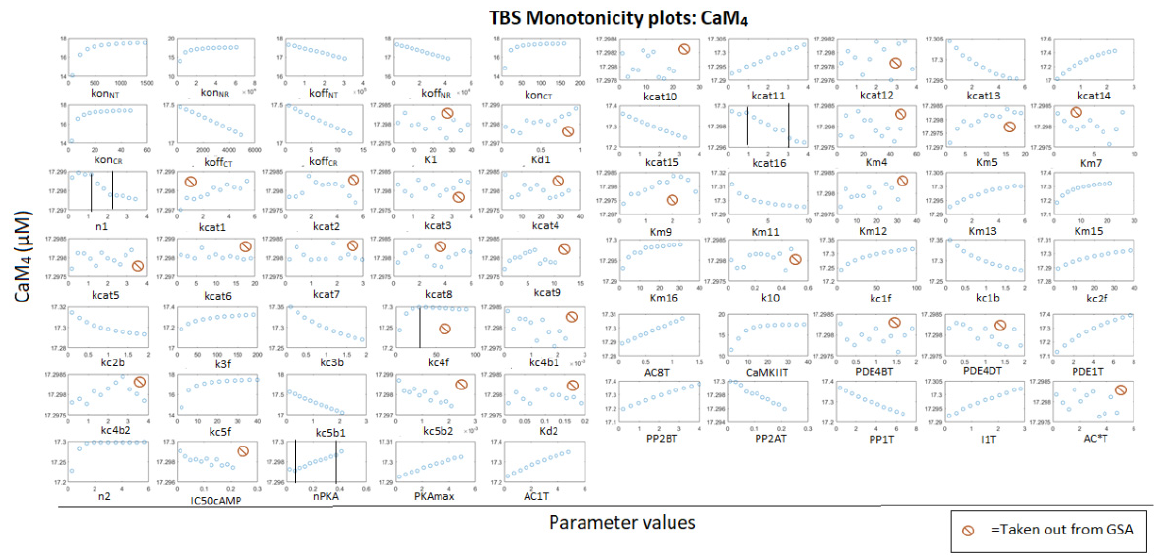
Figure B. Monotonic plots for CaM 4 during TBS. Note that napkin is trimmed to ±80% perturbation; Figure A1. Monotonic plots for CaM 4 during TBS. Note that napkin is trimmed to ± 80% perturbation; n1 was trimmed to ±40%; kcat16 was trimmed to ±70%. n1 was trimmed to ± 40%; kcat16 was trimmed to ±